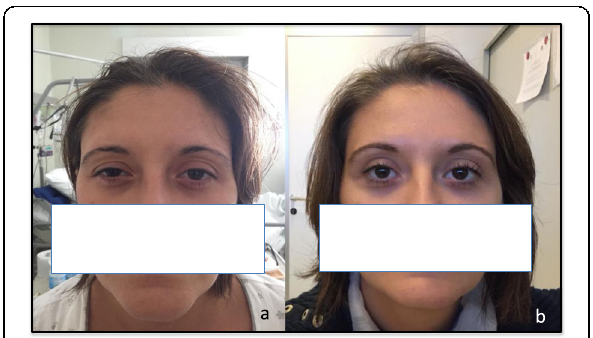
Fig. 1 (abstract P180). Right eyelid ptosis and conjunctival injection during pain exacerbations (a); normal eyes after bilateral YAG-laser iridotomy